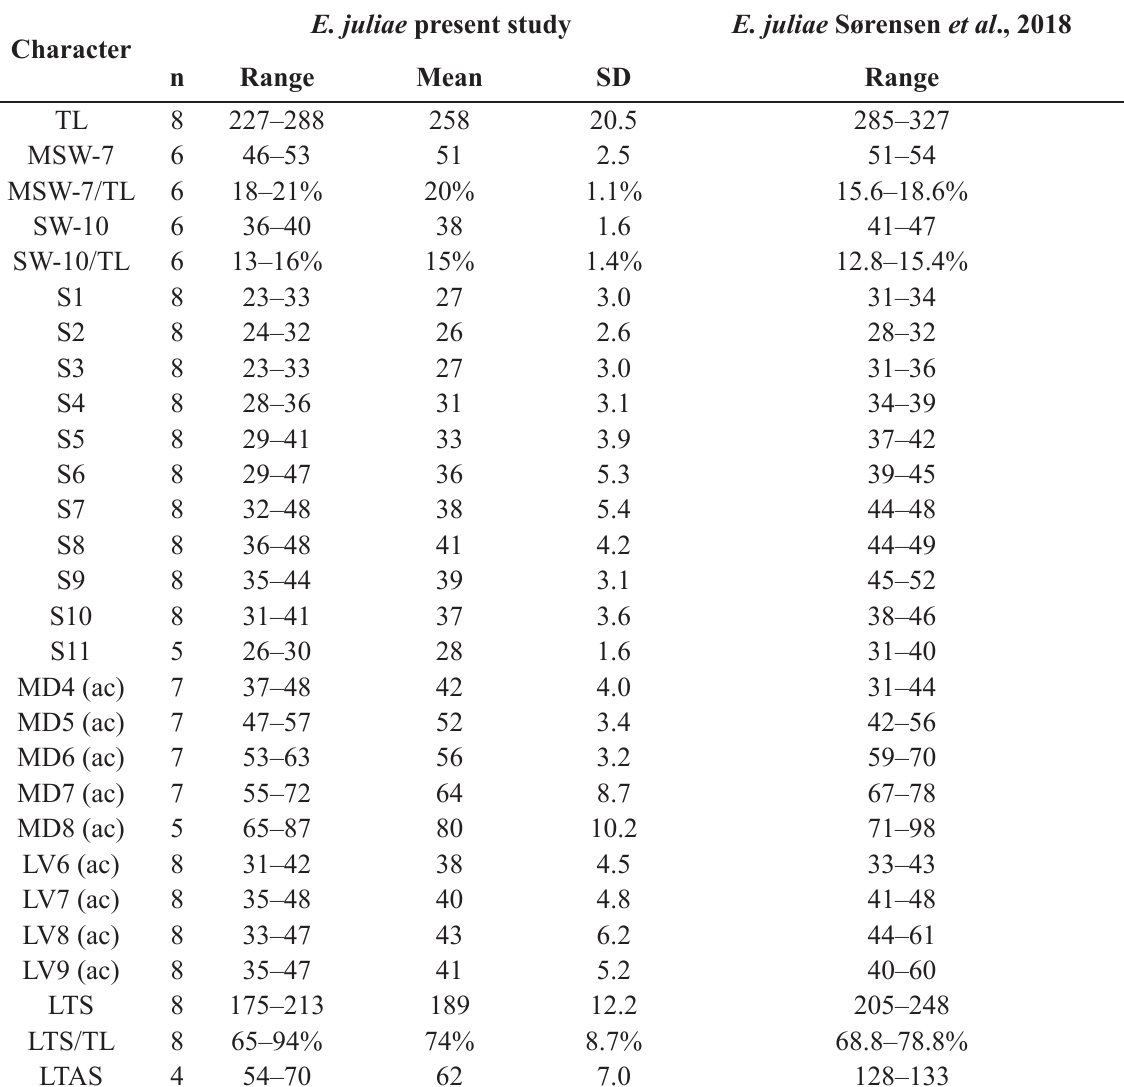
Table 28. Measurements from light microscopy of Echinoderes juliae Sørensen et al ., 2018 (in µm) from the Hikurangi Margin with comparison of measurements for E. juliae from its type locality, including number of measured specimens (n) and standard deviation